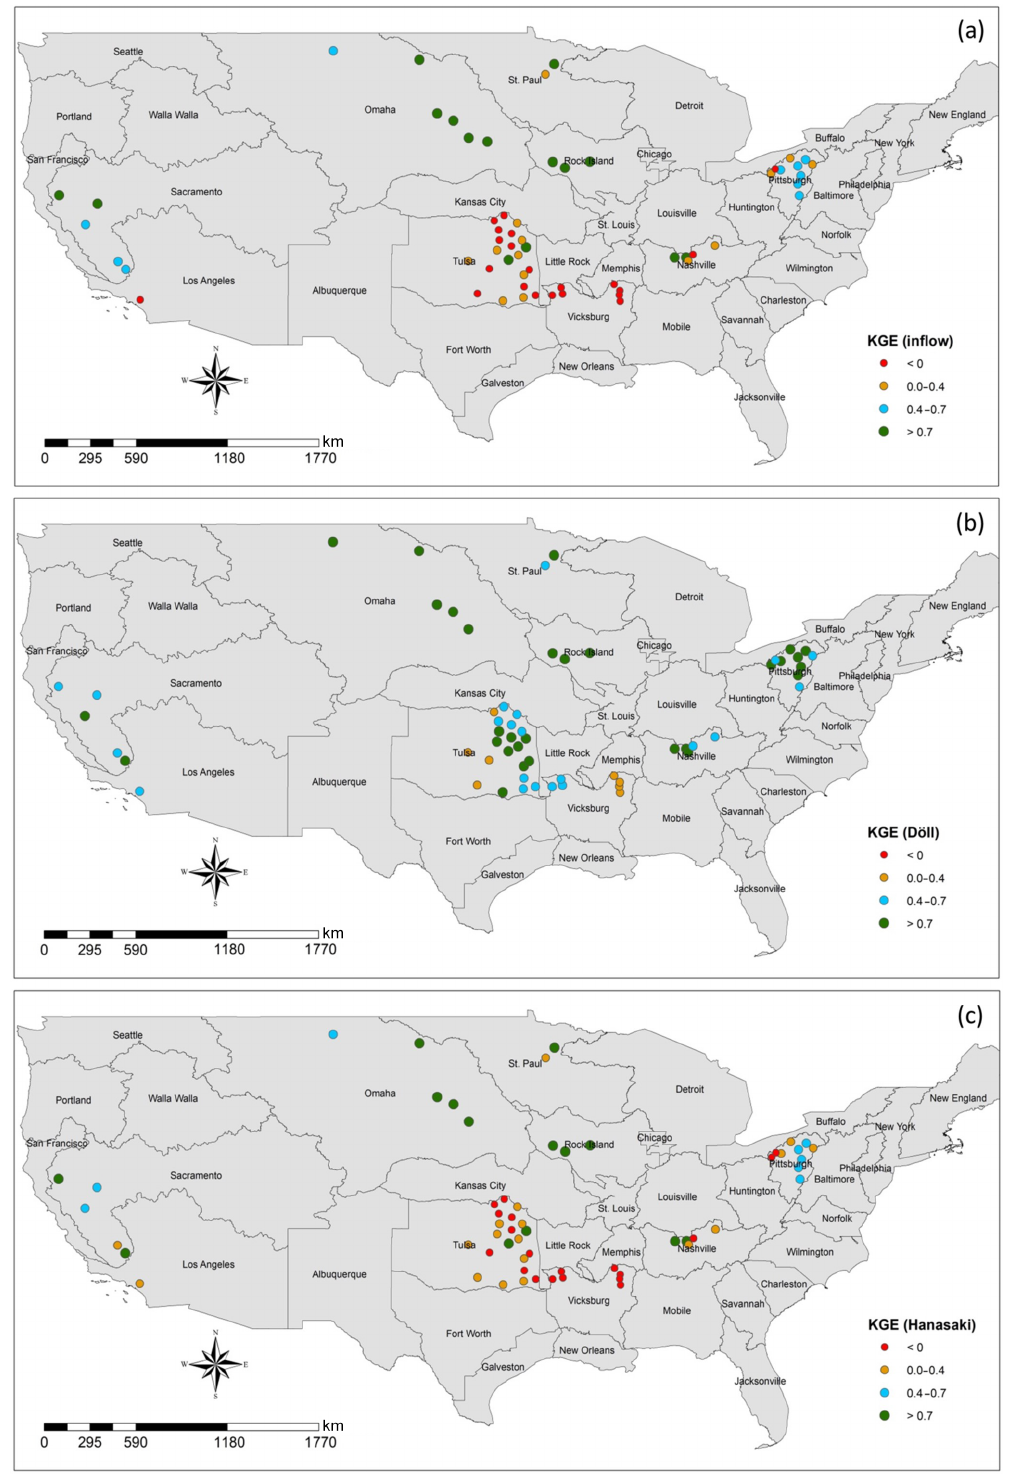
Figure 3. Spatial distribution of KGE comparing observed daily outflow to each best estimate of outflow: (a) observed inflow, (b) Döll method simulated outflow, (c) Hanasaki method simulated outflow for all reservoirs in this study. KGE values for the Döll method and the Hanasaki method are the maximum KGE values from all coefficient